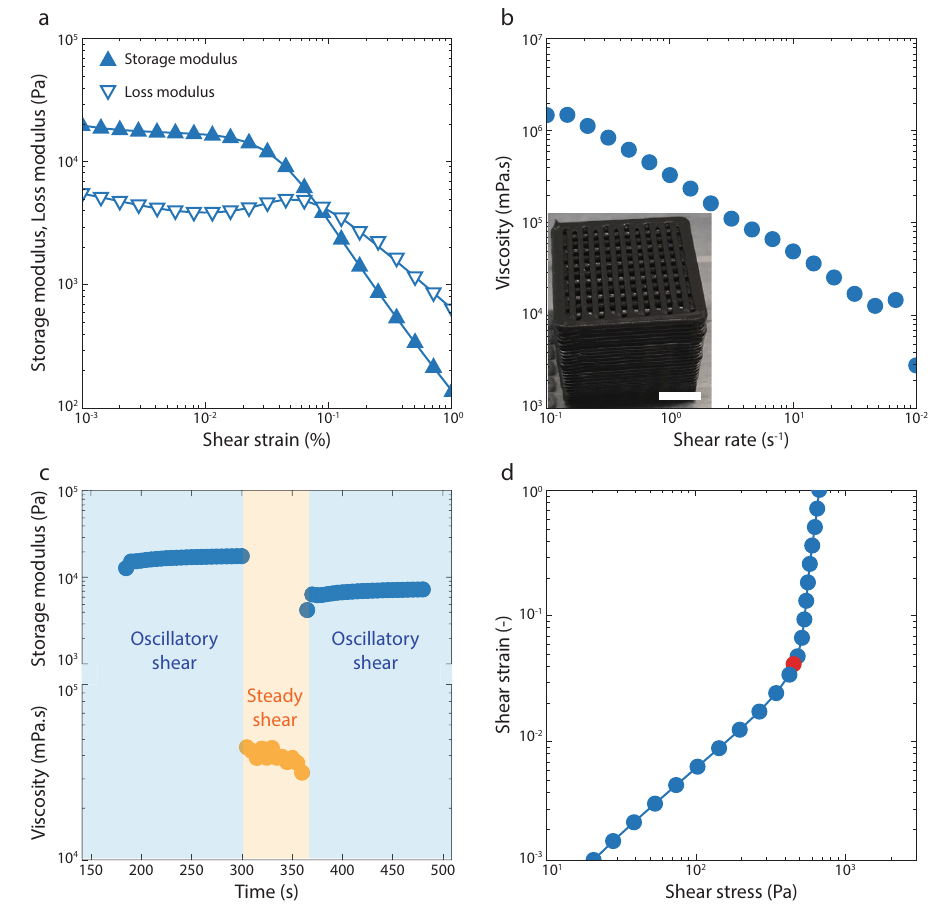
Fig. 2 | Rheology of a representative colloidal ink. a Storage ( G ′ ) and loss ( G ′′ ) moduli of the ink as a function of the magnitude of the applied oscillatory shear strain. b Apparent viscosity of the ink as a function of the shear rate applied in a steady-shear experiment. The inset shows an as-printed object with a grid-like architecture. Scale bar: 5mm. c Elastic recovery experiments that simulate the printing process through a sequence of oscillatory, steady-shear, and oscillatory measurements.Theoscillatorytestsareperformedbeforeandaftertheapplication